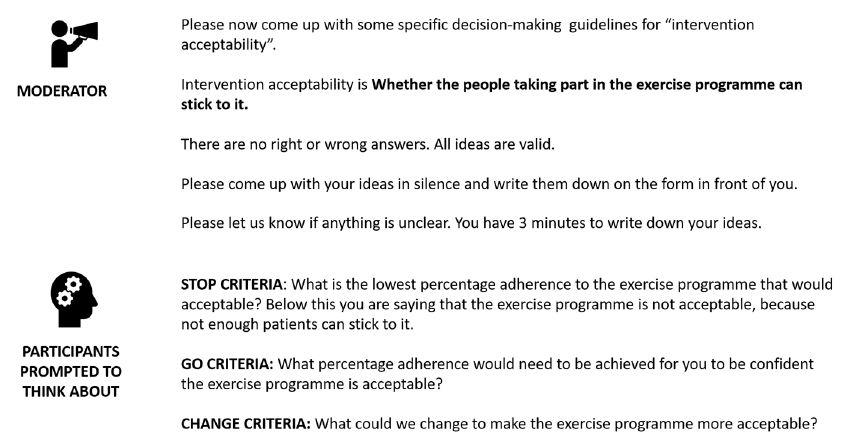
Figure 3. Example of how group members were prompt to consider the progression criteria, using intervention acceptability as an example.